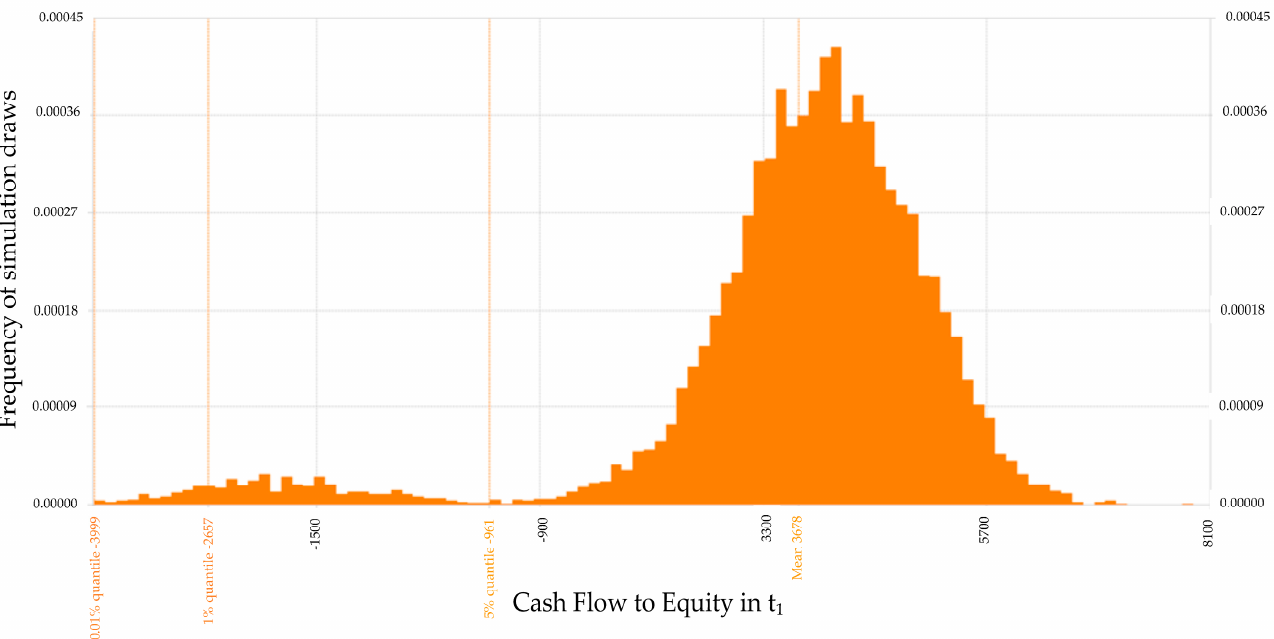
Figure 1. Histogram of cash flow to equity in t 1 .